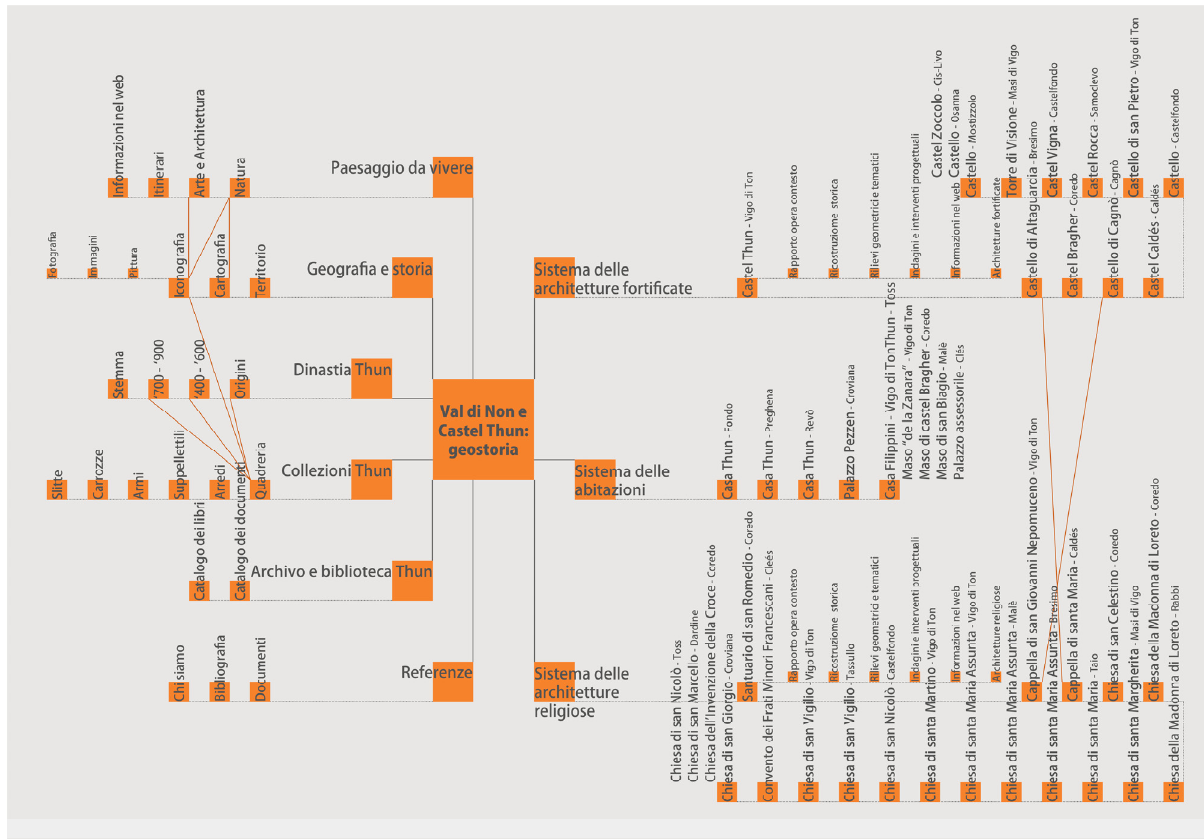
Figure 5. Conceptual map of the informative system “Val di Non e Castel Thun: